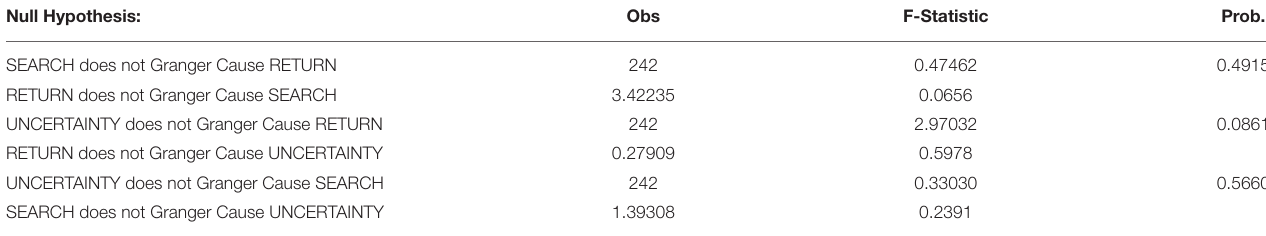
TABLE 3 | Granger test